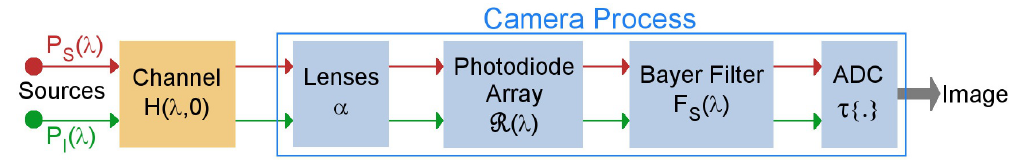
Figure 3. OCC System